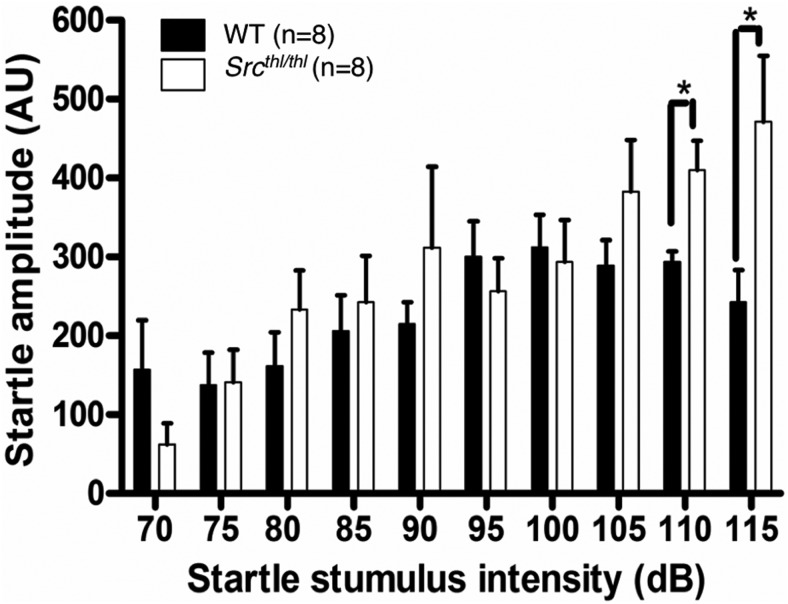
Acoustic startle in response to high startling stimulus is increased in Srcthl/thl mice. Both the WT and Srcthl/thl mice exhibited similar startle amplitude responses to the low-intensity acoustic stimuli (70-105 dB). Srcthl/thl mice showed higher responses to the high-intensity stimuli (110-115 dB) (n = 8 WT (8 males), n = 8 Srcthl/thl (18 males)). *p < 0.05.